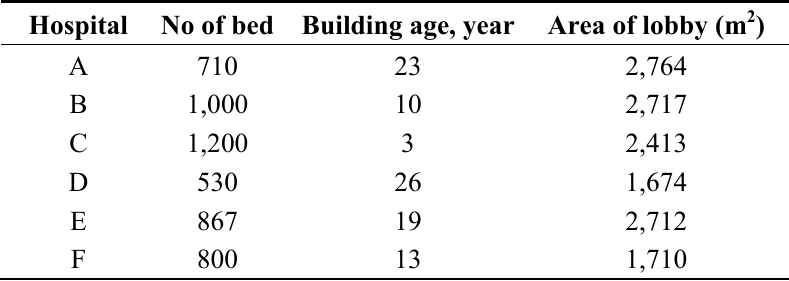
Table 1. General characteristics for the hospitals